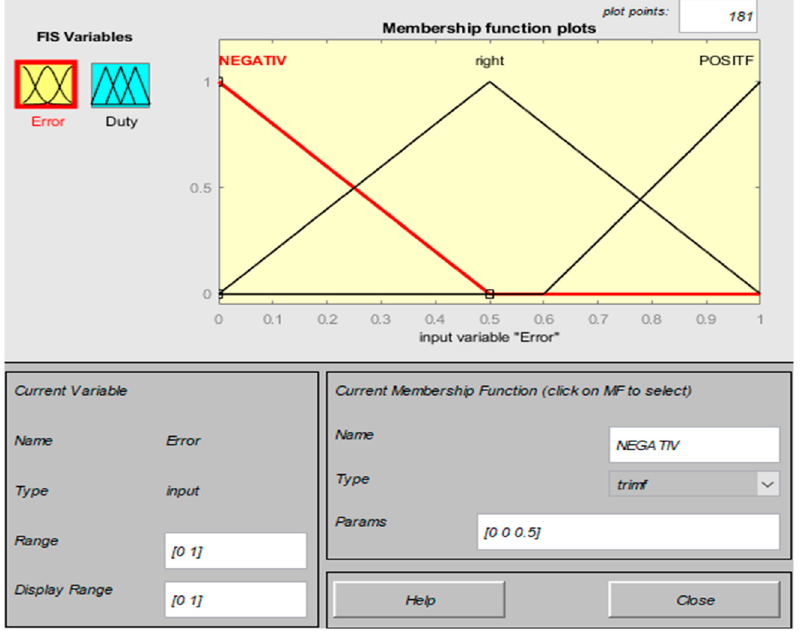
Figure 8. Error signal membership functions.